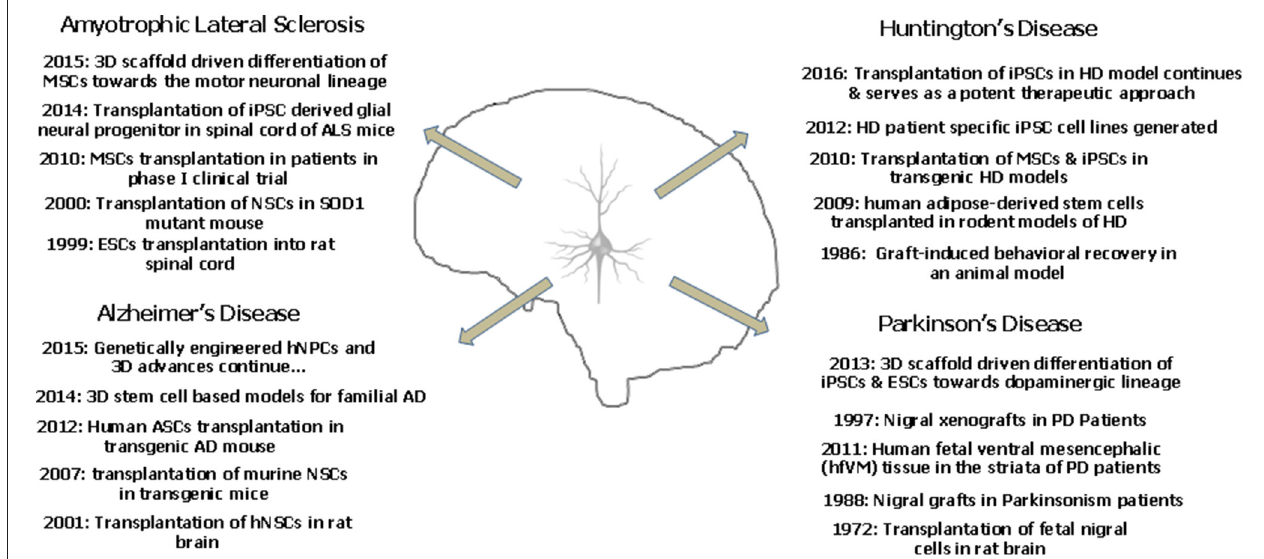
FIGURE 2 | The landmark studies/discoveries (5 each) related to the major neurodegenerative disorders and the possible role of stem cells in a time oriented manner.